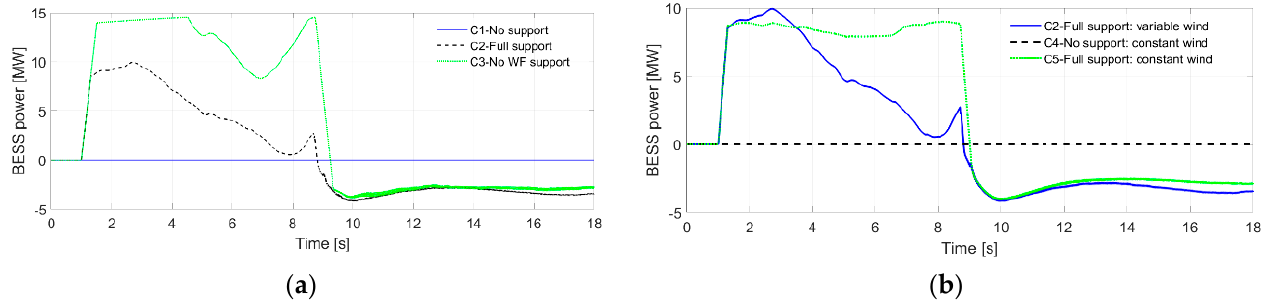
Figure 12. BESS total power: ( a ) variable wind speed; ( b ) constant wind speed compared to Case 2.